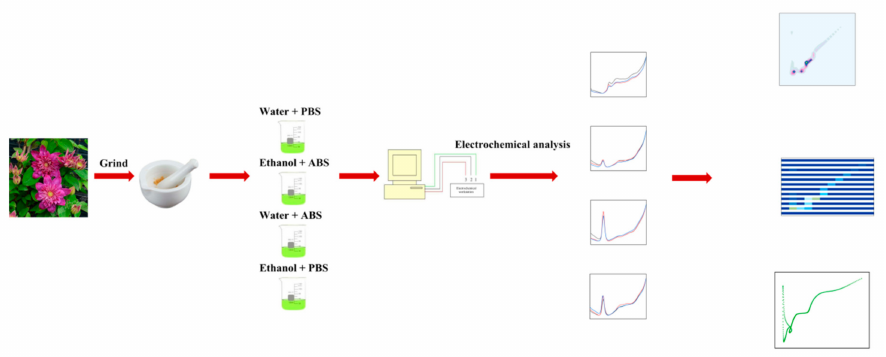
Figure 1. Schematic diagram of the steps involved in the electrochemical approach applied to the of Clematis variety